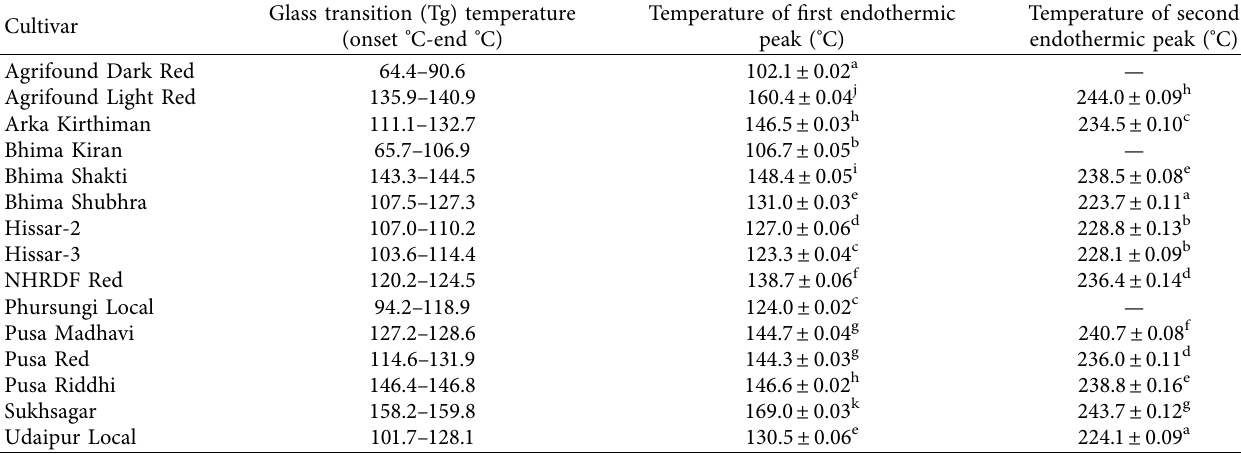
Table 4: Glass transition temperature (Tg) of onion skin powder of fifteen cultivars.